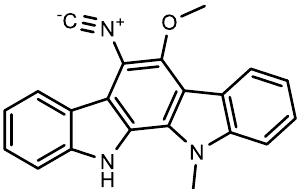
Figure 9. Structure of 6-cyano-5-methoxy-12-methylindolo [2,3A] carbazole ( 13 ).